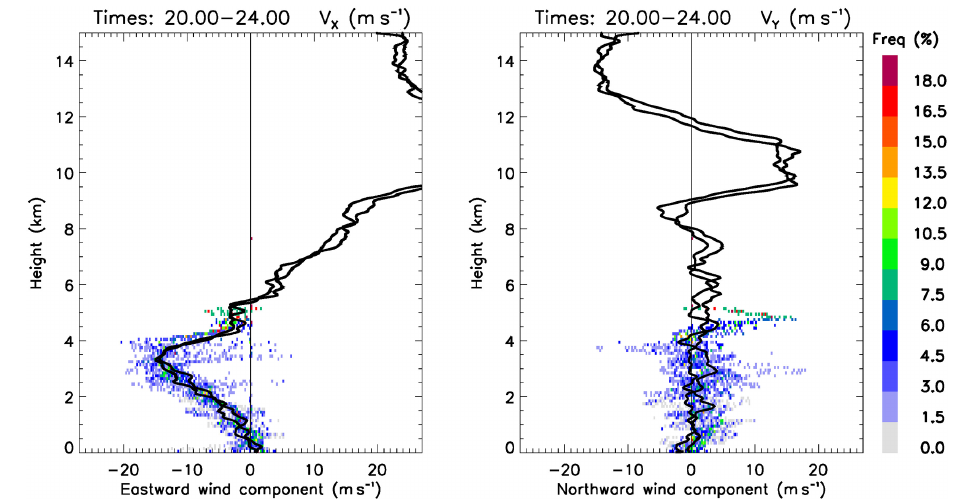
Figure 5. Same as Fig. 3 but for the cumulus congestus case and the 20:00–24:00LT period on 24 November 2019.